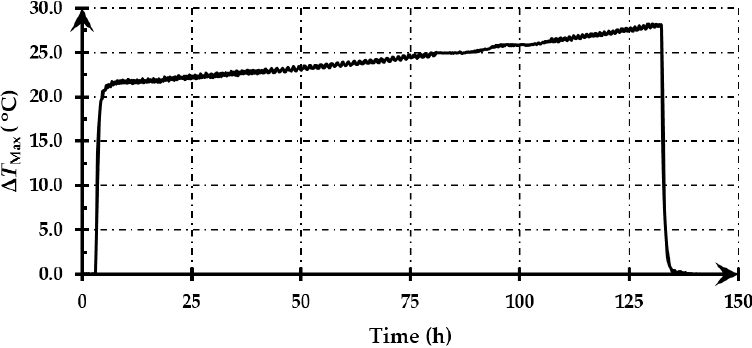
Figure 12. Chart showing variation of maximum temperature increments maximum temperature increment ( Δ T Max ) during test U = 3.6 V, I = 3200 mA.